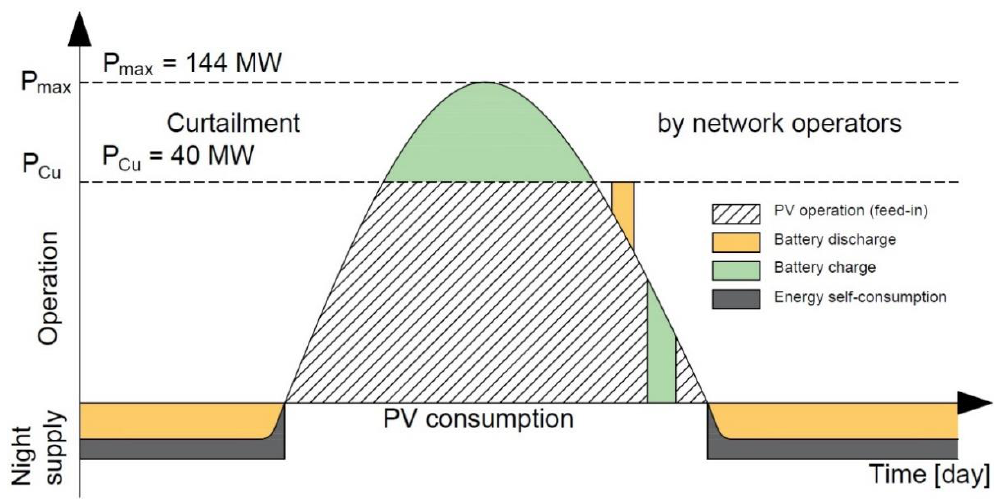
Figure 8. Operation procedure of the PV farm in Germany with BES—study case B.